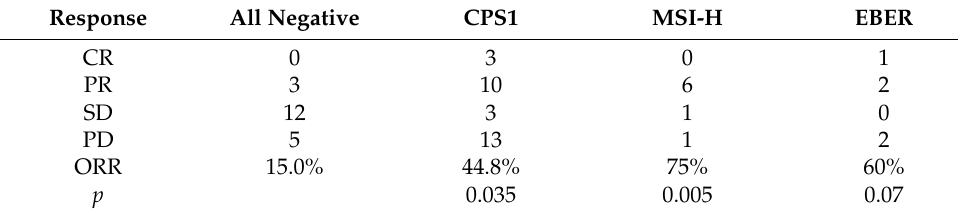
Table 2. Outcomes for different